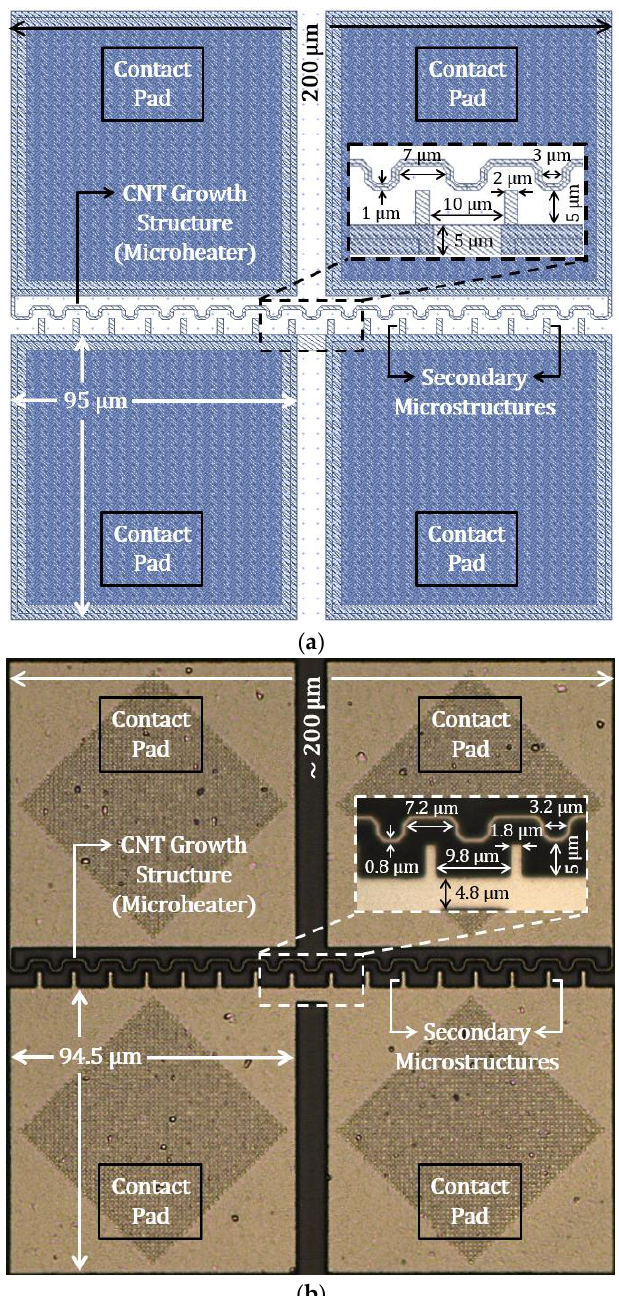
Figure 9. Aluminum CNT growth structures in AMS 350 nm process: ( a ) layout design and ( b ) optical micrograph.